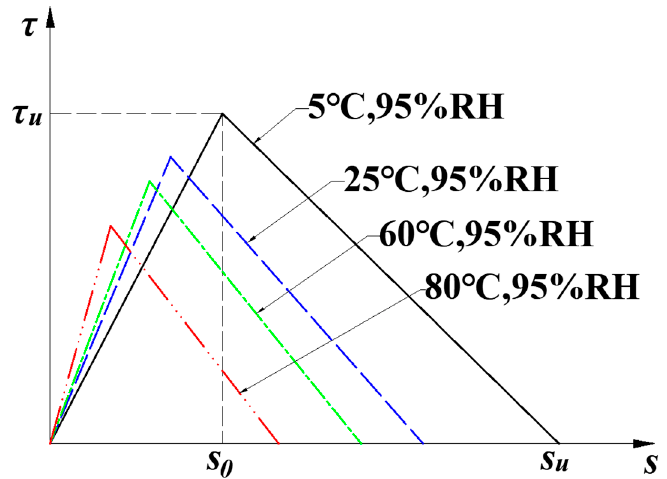
Figure 1. Bilinear bond–slip relationship with different hygrothermal pretreatments.